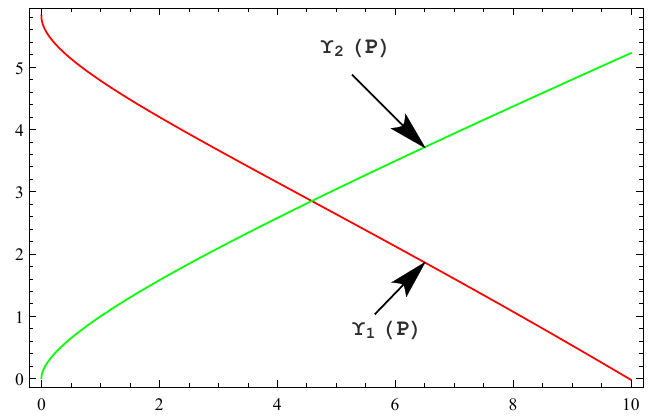
Figure 1. Existence of the unique positive fixed point of System